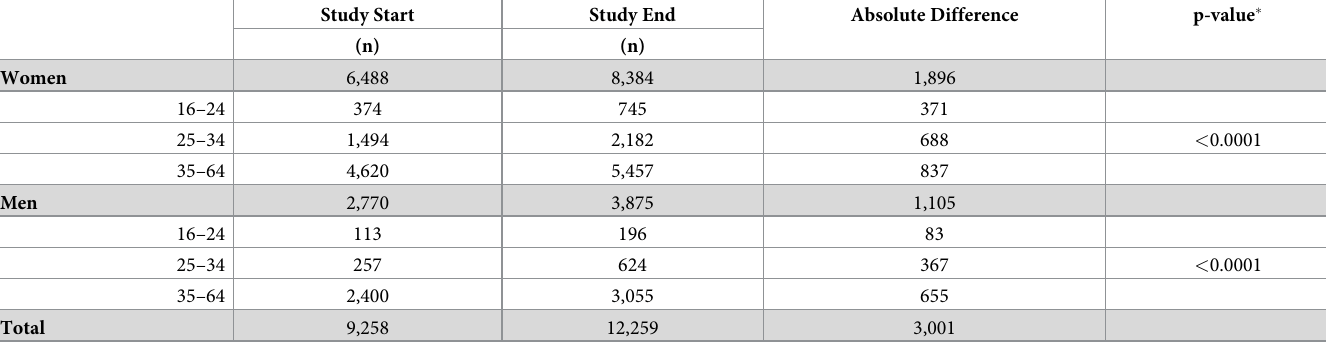
n, number of participants � Rao-Scott Chi-Square test for difference in overall proportion; �� Significant at α =